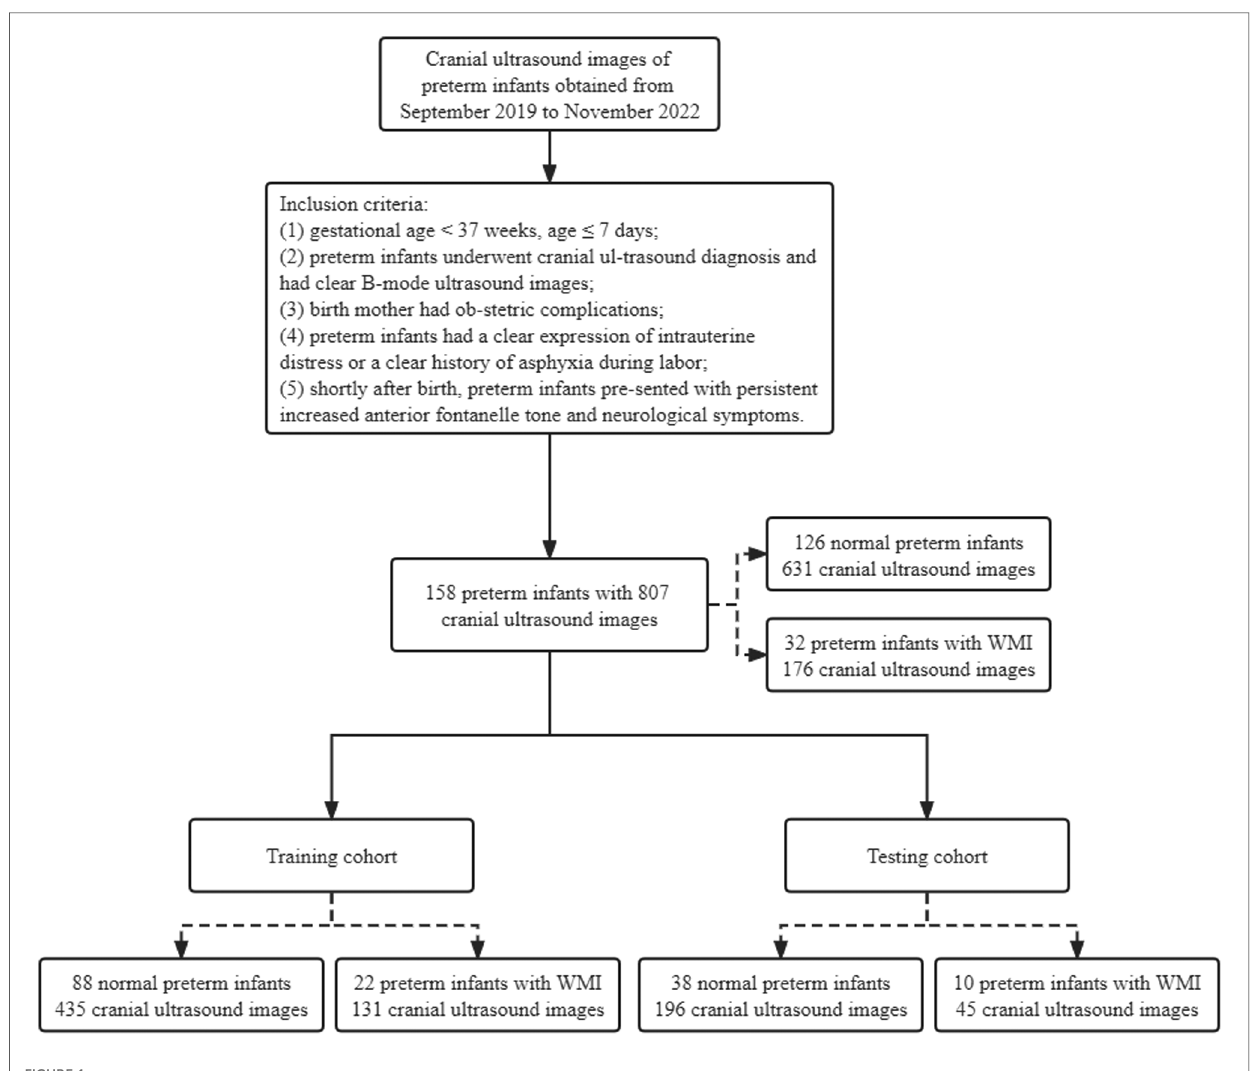
FIGURE 1 Overview of the patients of the